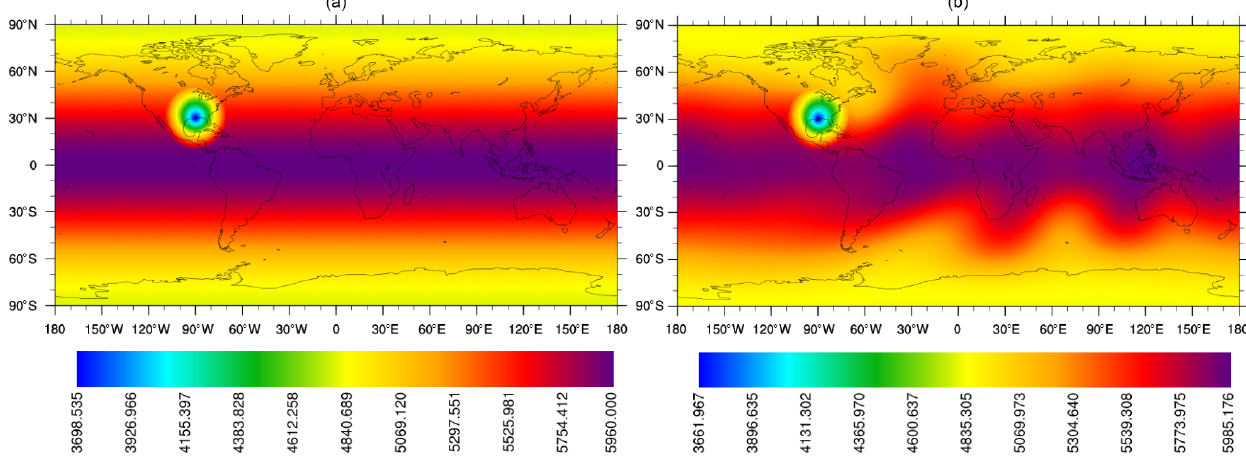
Figure 4. The initial thickness h 0 (z 2 ) with z 2 = 23 . 82865m (a) and the thickness h after 10d (b) and the mountain height h b (z 1 ) with z 1 = 2023 . 78m.